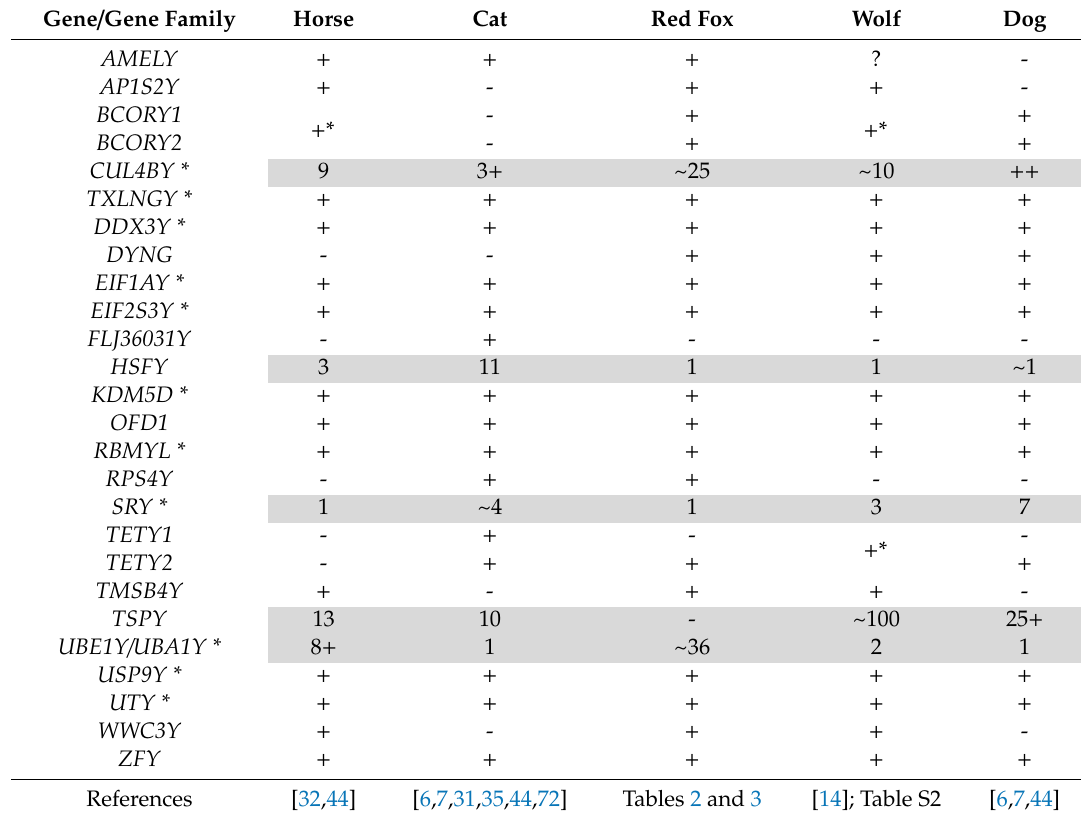
Table 6. Summary of gene status in horse, cat, grey wolf, dog, and red fox based on the current literature. Grey shading indicates genes for which copy number estimates were available in all five taxa, and an estimated copy number is provided in these cells. Wolf estimates for AMELY, FLJ36031Y , and RPS4Y were determined by BLAST against the wolf reference genome using the same parameters used in the fox versus cat analysis (Table S2). Starred gene names (*) indicate the 11 core carnivore Y-chromosome genes [31]. +/ - indicate binary presence / absence of gene based on current literature. ++ indicates genes that are multicopy but with no estimate of copy number specified. The question mark (?) indicates uncertainty about gene status. + * indicates ambiguity in the literature about which copy of a duplicated gene was